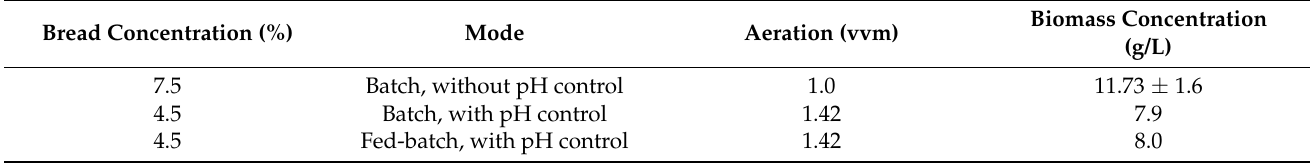
Table 4. Biomass concentrations after 48 h of cultivation in the 26 L bioreactor.